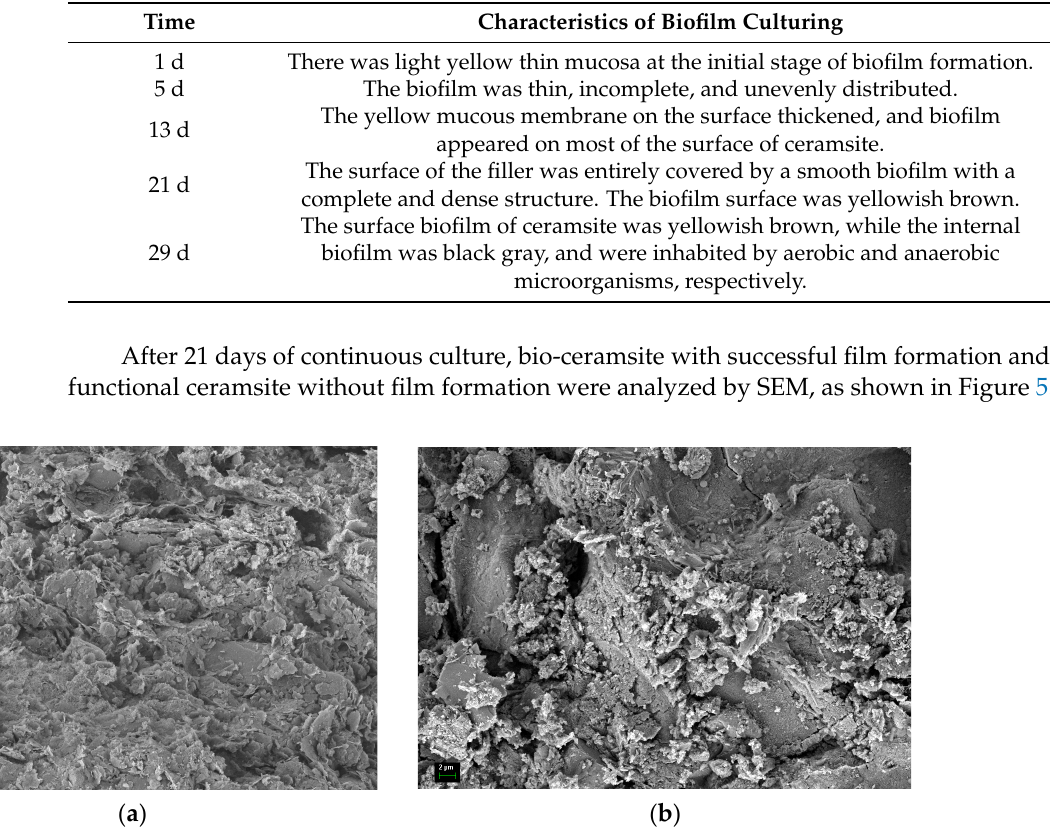
Table 3. Characteristics of the biofilm on bio-ceramsite.